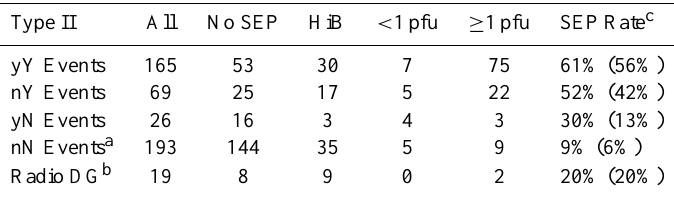
Table 3. SEP association rate among various FW CME populations.